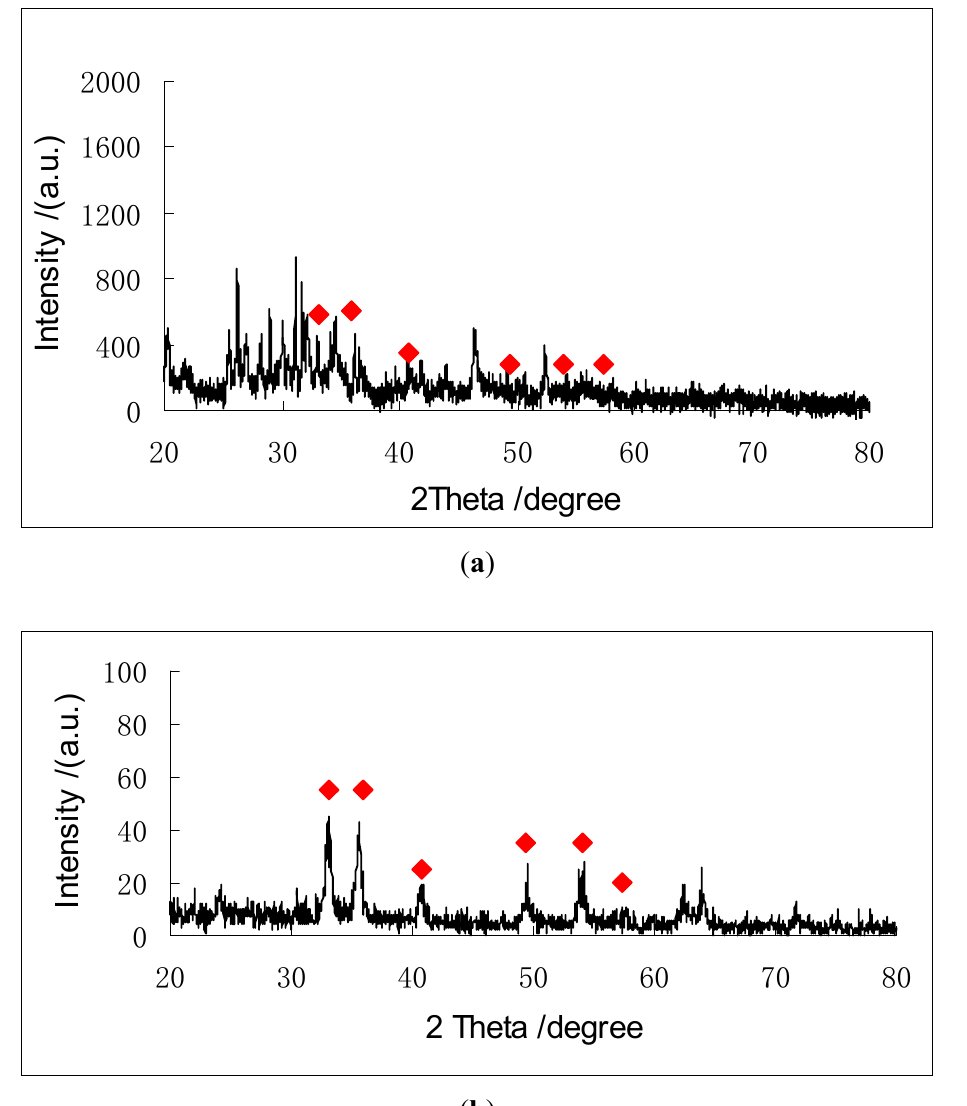
O samples: ( a ) Hollow ball; ( b) Solid ball. 2 3